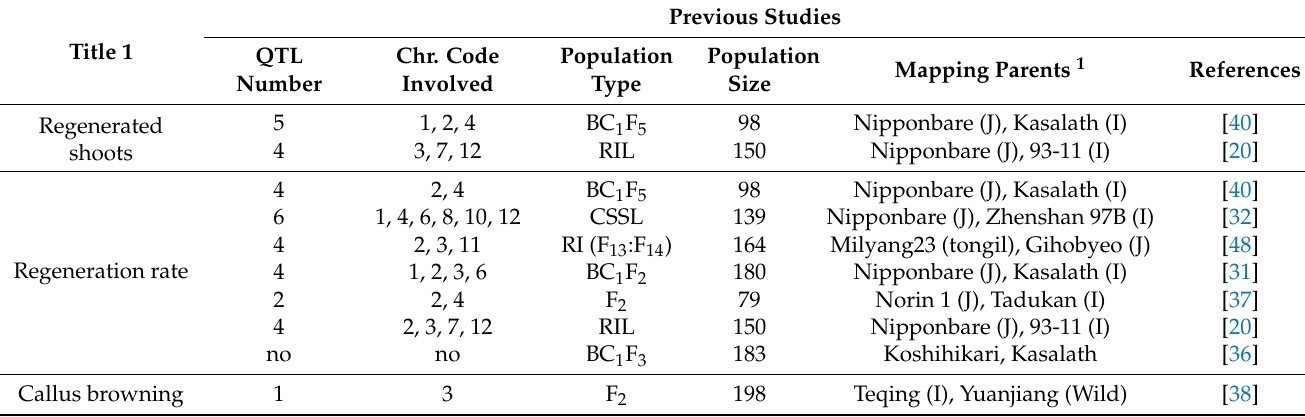
Table 3. QTLs identified from previous studies of regeneration-related ability in